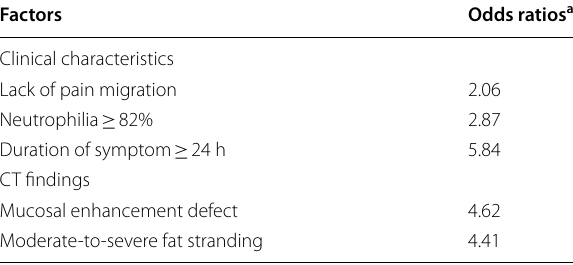
Table 6 Summary of statistically significant factors predictive of complicated